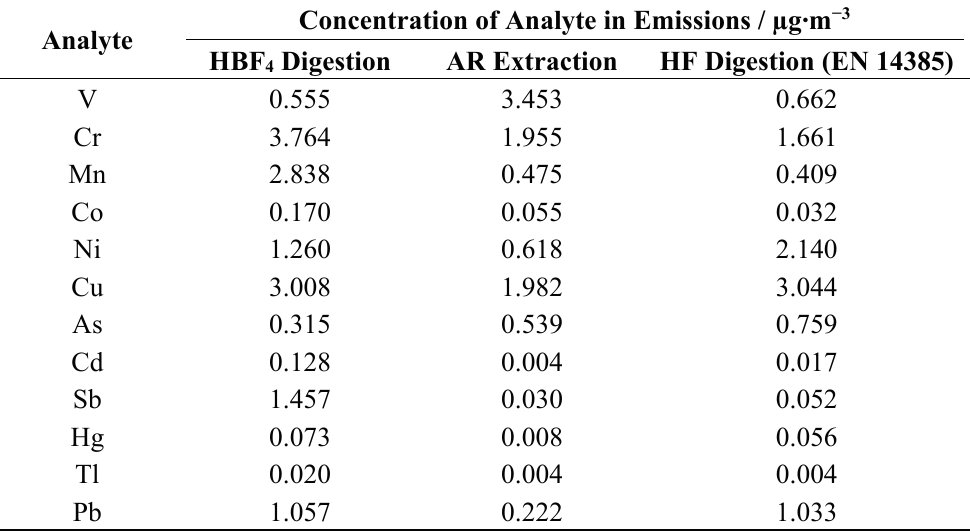
Table 4. Maximum LOD values (filters) expressed as concentrations of analyte in